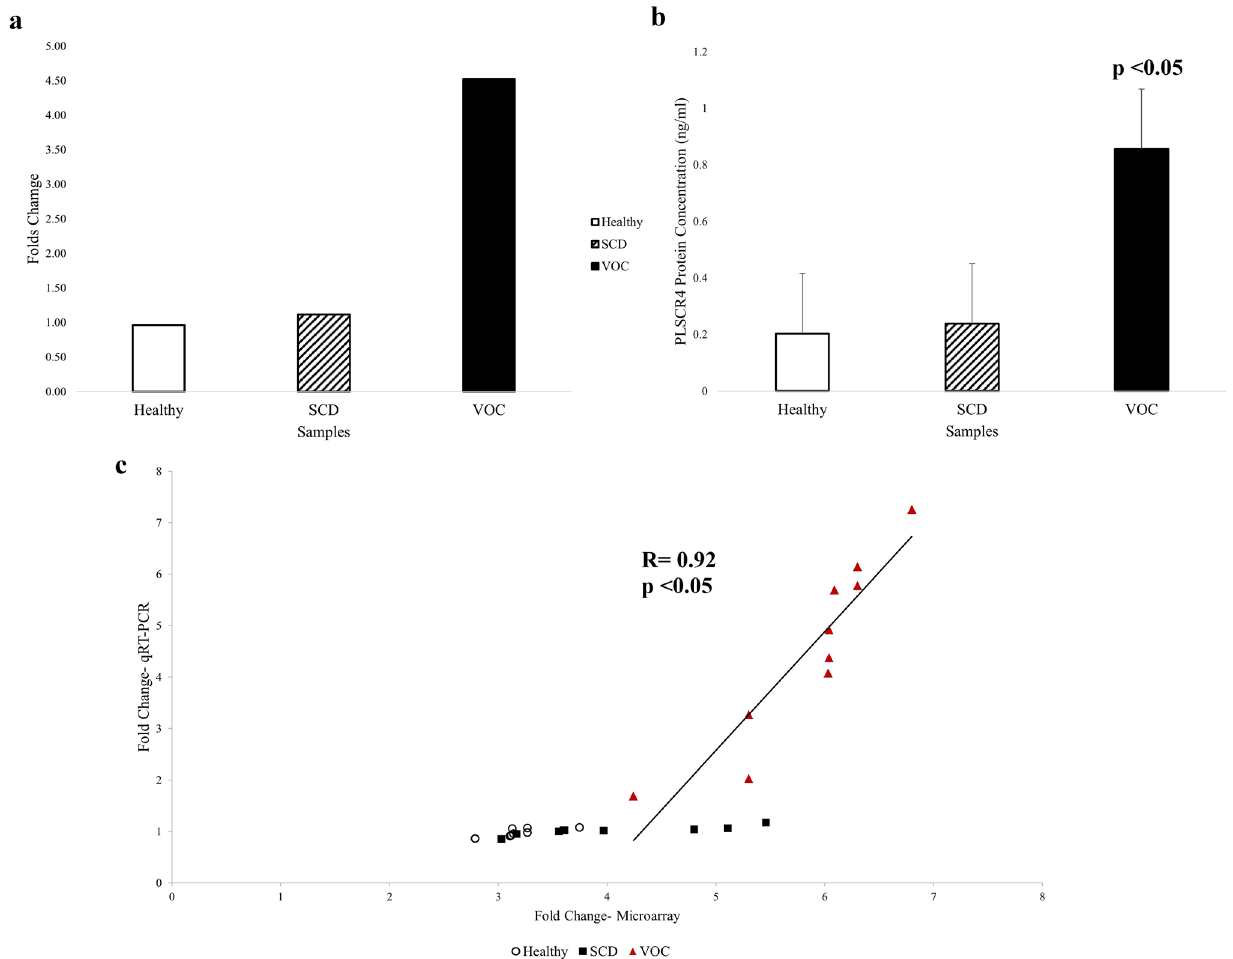
Figure 4. PLSCR4 gene expression level and protein concentration. ( a ) Average folds change of PLSCR4 gene through real-time polymerase chain reaction (qRT-PCR) showing 4-folds up-regulation in SCD patients in VOC compared to SCD patients in steady-state at a p -value of 0.00017. ( b ) The average PLSCR4 protein concentration was increased in SCD patients in VOC compared to SCD patients in steady-state at a p -value of 9.072 × 10 –6 . ( c ) Correlation of fold change of PLSCR4 gene expression measured by microarray and qRT-PCR. X-axis represents log2-fold change determined by microarrays; y-axis represents log2-fold change determined by